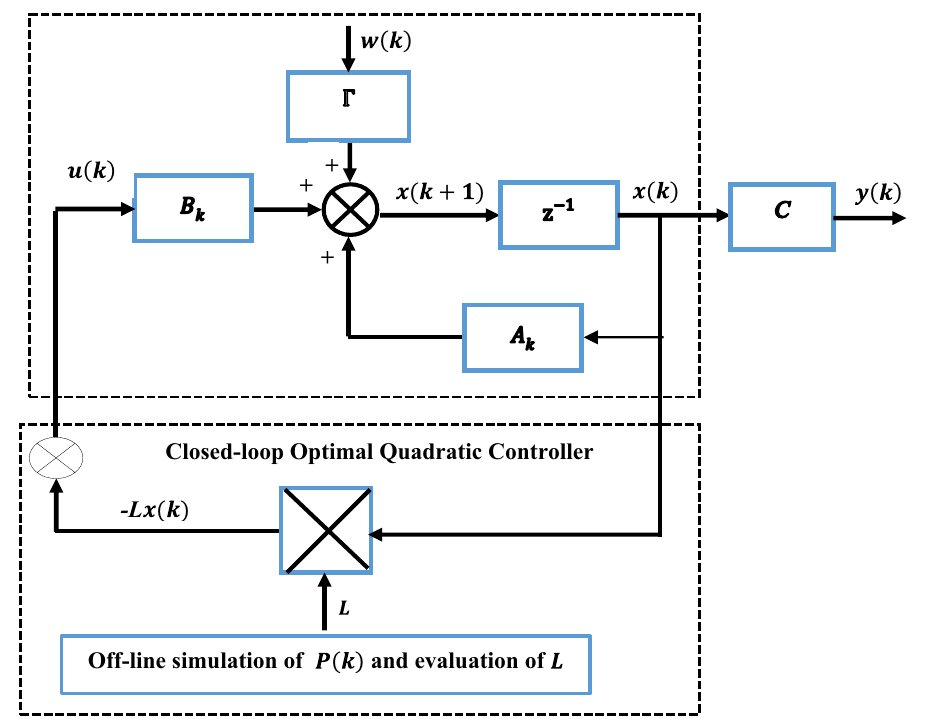
Figure 1. Closed-loop for an optimal control system with